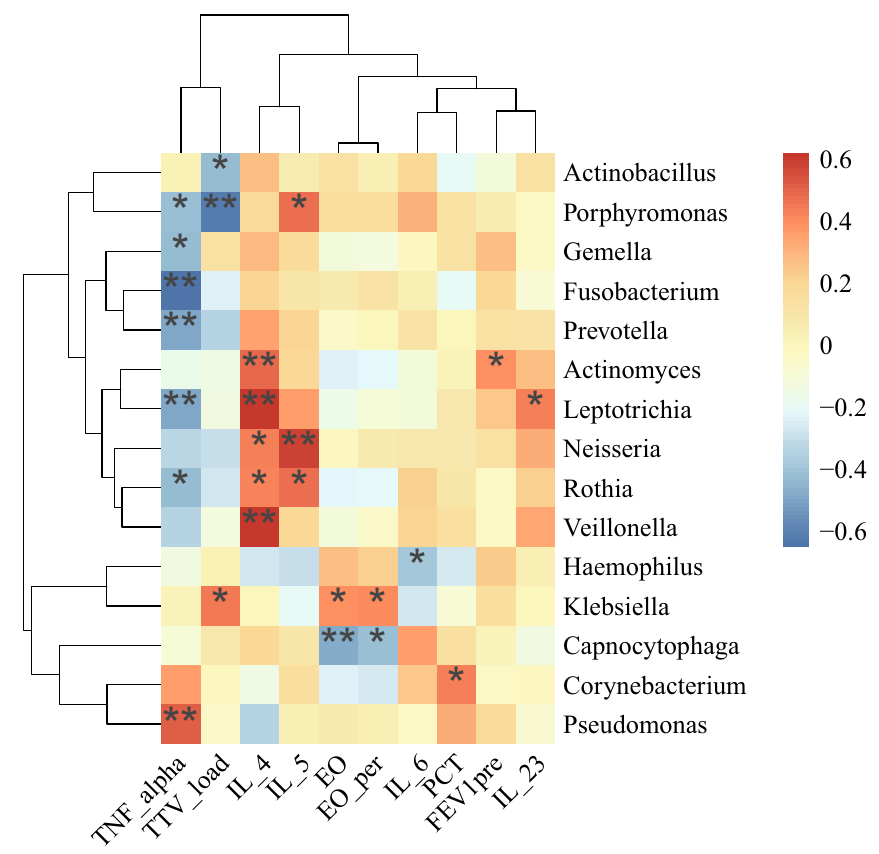
Figure 4. Heatmap of Spearman correlation analysis between the relative abundances of sputum microbiome and the clinical indices. TNF tumor necrosis factor, IL interleukin, TTV torque Teno virus, PCT procalcitonin, EO eosinophils. * p < 0.05, ** p <